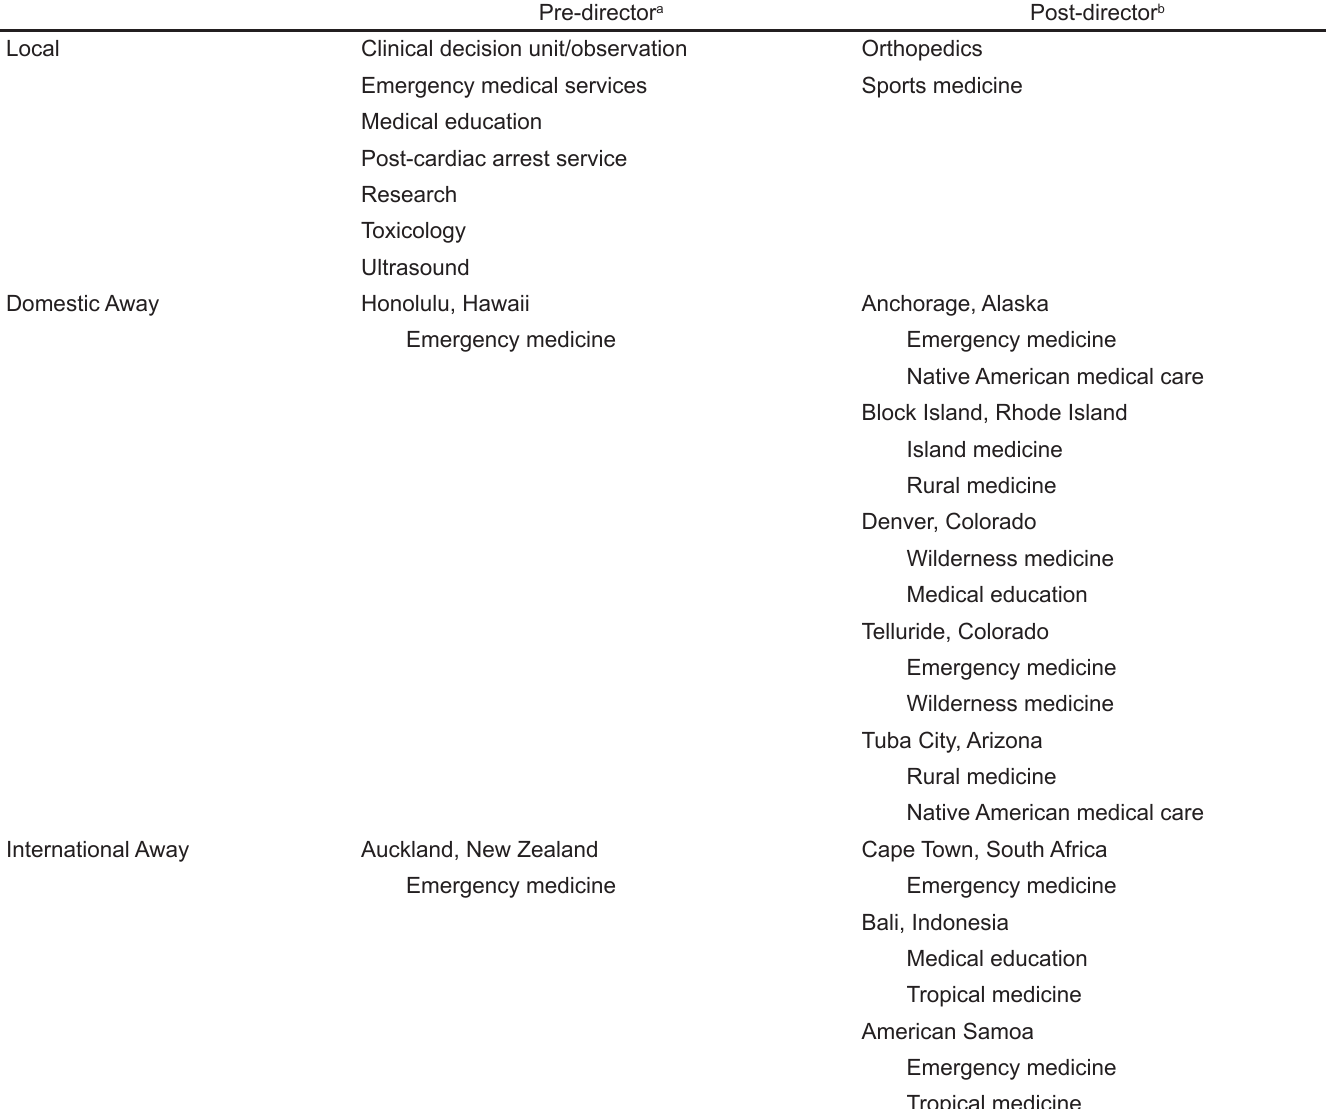
Table 1. Elective rotations including location and description of away